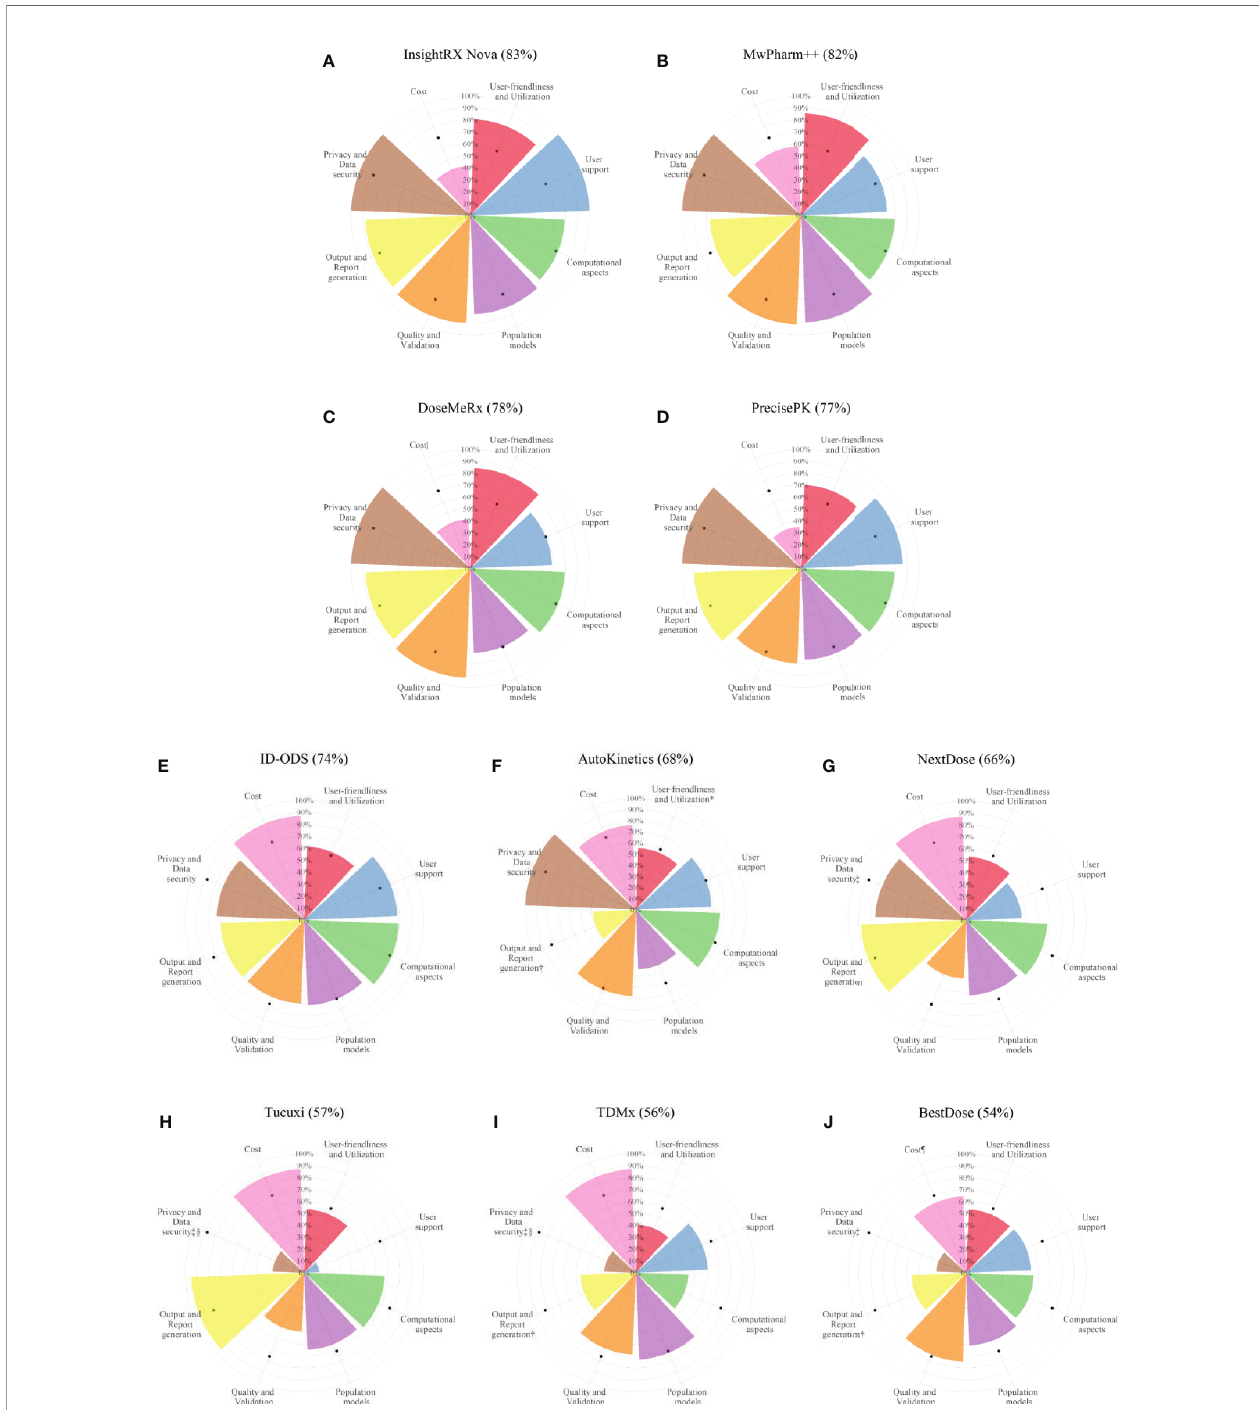
FIGURE 5 | Ful fi llment of the considered criteria in the eight categories by each of the evaluated software tools. Numbers in parentheses are percentage of the overall performance scores. Software tools are ranked in decreasing order of overall performance scores [from the highest score (A) to the lowest score (J) ]. Black solid circles in each category represent the median ful fi llment (%) of the considered criteria by the 10 evaluated software tools. *Manual data entry not possible. † A report cannot be generated. ‡ The data privacy method in data collection cannot be evaluated since no data are collected in the software. § Database encoding cannot be evaluated since no data are stored in the software. | An individual license is not available. ¶ An institution license is not